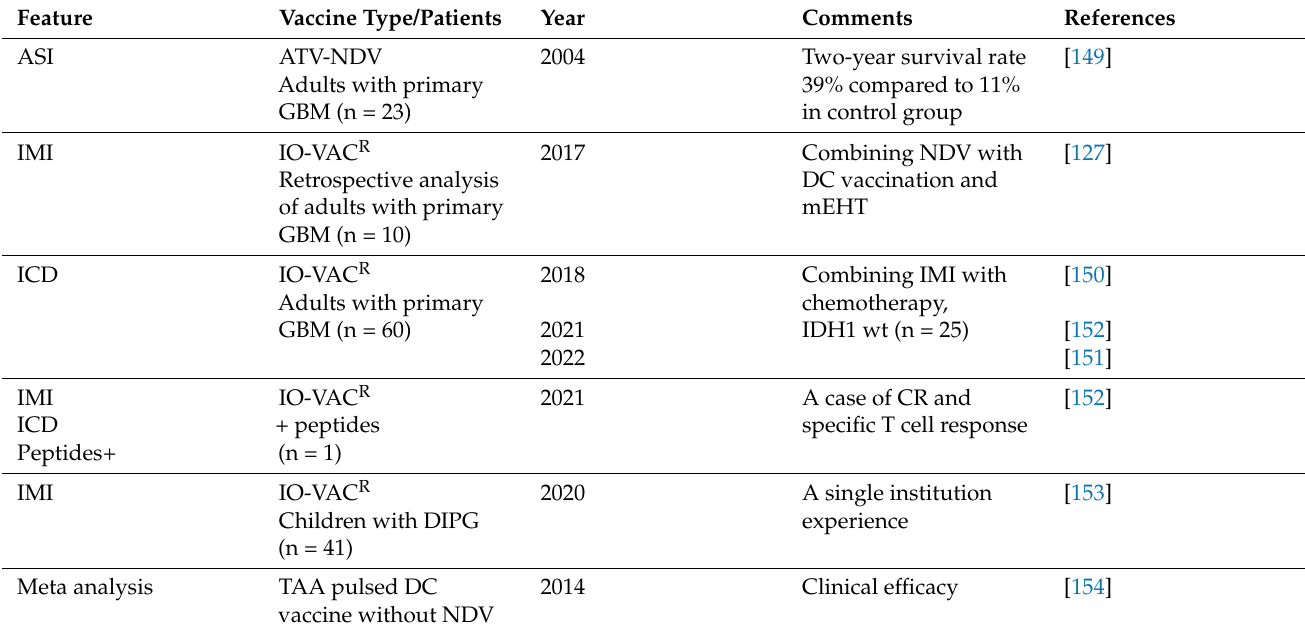
Table 4. Post-operative vaccination with or without NDV of glioblastoma patients. Feature Vaccine